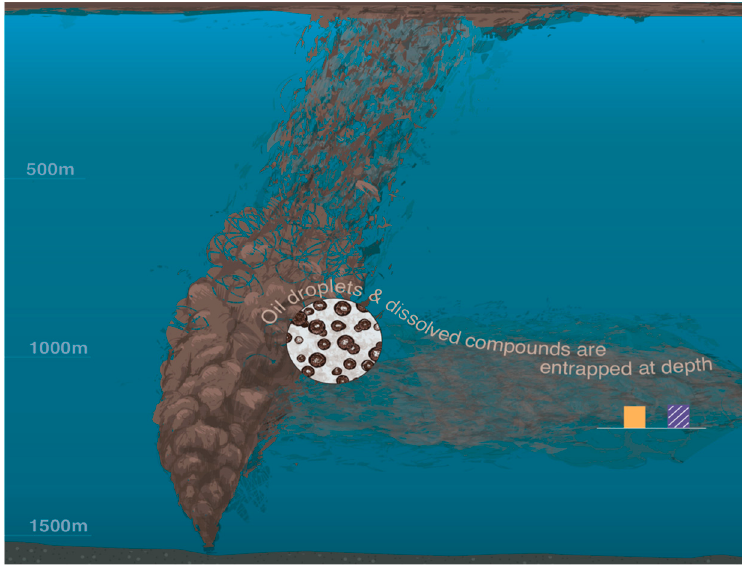
Figure 8. Schematic of a deep sea release from a well blow-out.